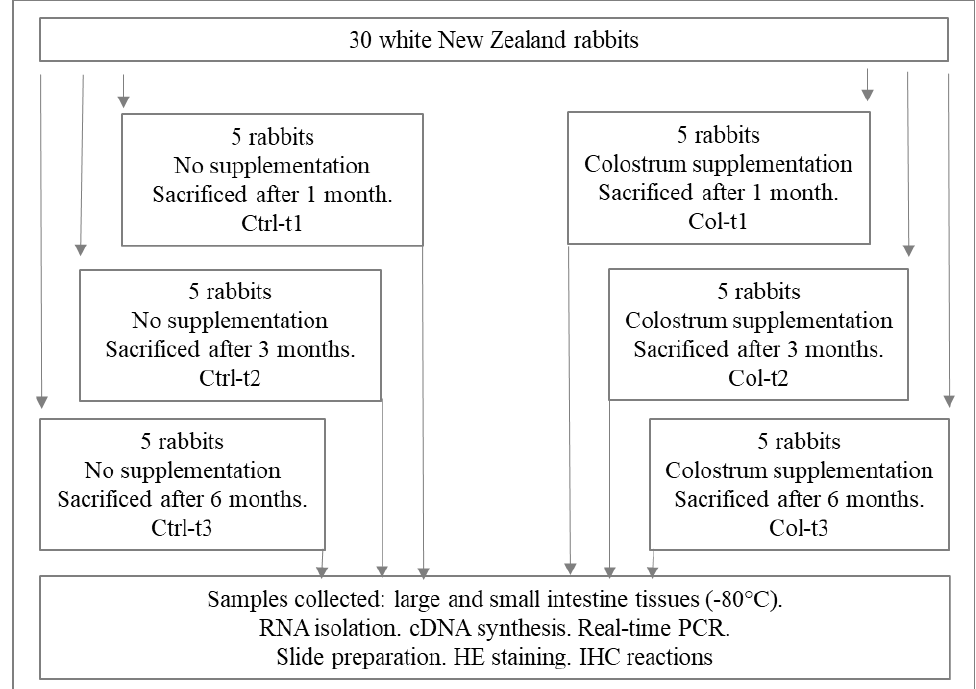
Figure 1. Graphical overview of the procedure for obtaining biological material and division into test and control groups.